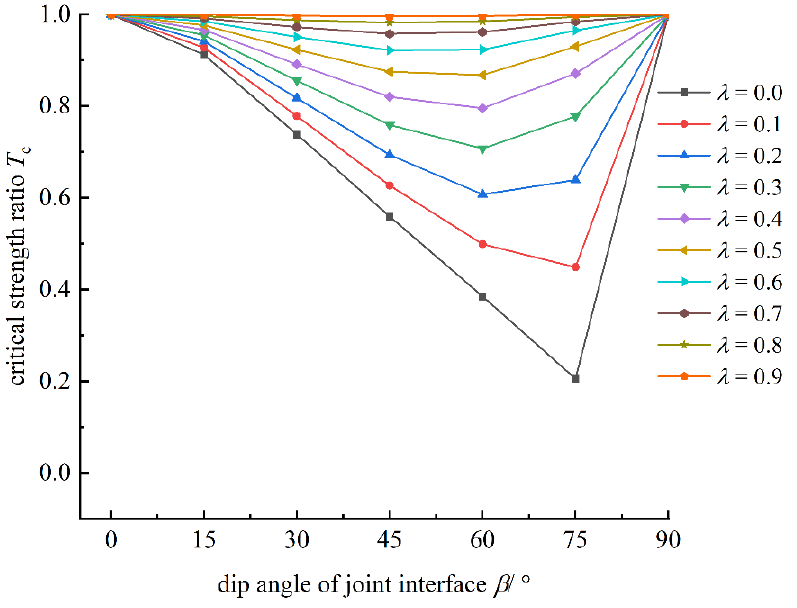
Figure 6. Results of critical strength ratio.